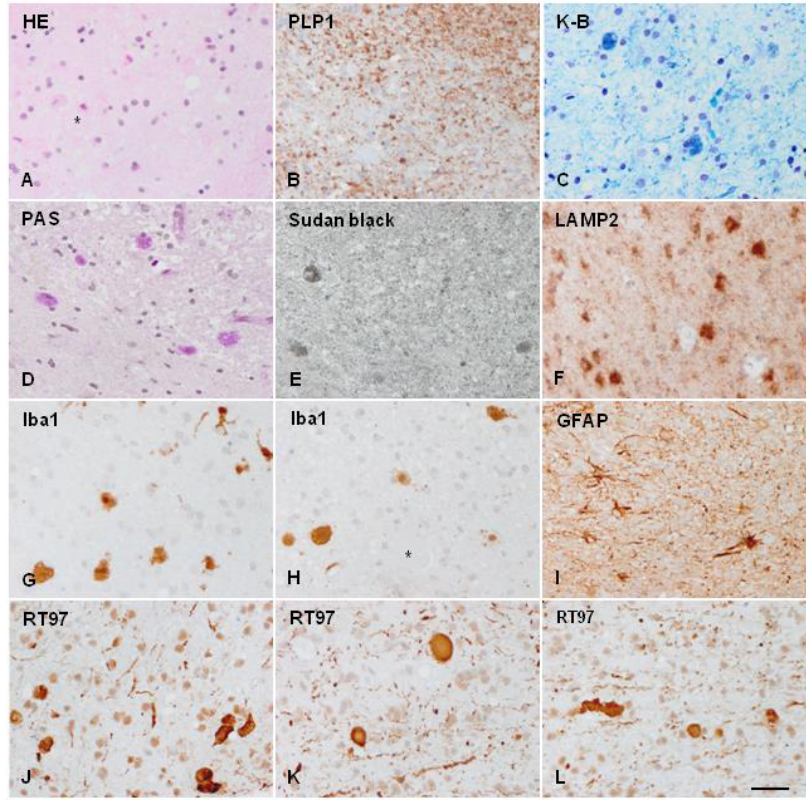
Figure 3. ALSP cerebral biopsy sample. ( A ) Axonal ballooning (asterisks) as seen in haematoxylin and eosin-stained sections. ( B ) Reduced proteolipid protein 1 (PLP1, a protein component of myelin) immunoreactivity. ( C ) Myelin loss and deposits of pigment in glial cells, as revealed by Klüver– Barrera (K-B) staining, demonstrating the presence of phospholipids in the pigment. ( D ) Pigmented glial cells are stained with PAS, and ( E ) Sudan black, showing the deposits of glucolipids and complex lipids; ( F ) glial cells showing the accumulation of lysosome-associated membrane glycoprotein 2 (LAMP2), a marker of autophagy. ( G , H ) Globose microglial cells and macrophages stained with allograft inflammatory factor 1(Iba1) antibody. ( I ) Moderate astrogliosis as revealed with glial fibrillary acidic protein (GFAP) immunohistochemistry. ( J – L ) different fields showing nerve fibre loss and abundance of axonal ballooning as revealed with the anti-neurofilament (200 kDa) antibody RT97. Paraffin sections, bar = 50 µ m. Details of case report reference